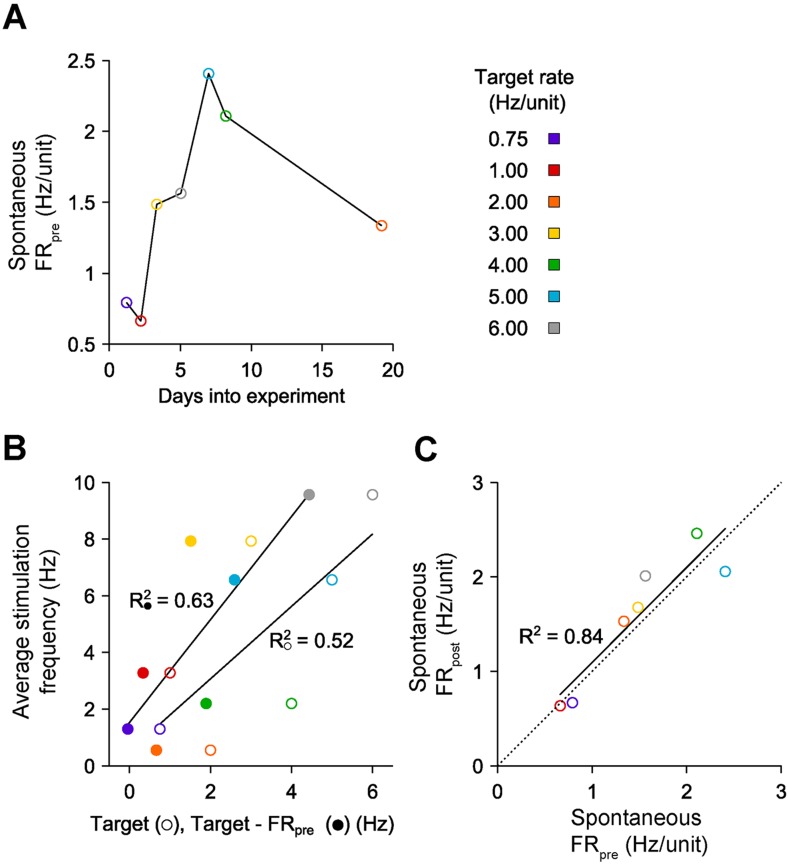
Characteristics of on-off control over weeks in vitro.(A) Spontaneous, pre-stimulation firing rates over the course of 7 long-term excitatory on-off control experiments with a single culture. Spontaneous excitability changes smoothly across the ∼20 days during which 12-hr firing rate control experiments were conducted. (B) The average stimulation frequency required to achieve firing rate control is plotted against the target rate (○) and the difference between the target rate the pre-stimulation spontaneous firing level (●). A linear fit is improved when the spontaneous excitability is taken into account, indicating that ongoing changes in network excitability influence the intensity of stimulation required to achieve firing rate control. (C) The spontaneous firing rate before each 12-hr protocol vs the spontaneous firing rate following each protocol exhibits a strong linear relationship (black line) that is not significantly different from identity (dashed line). This indicates the absence of a homeostatic decrease in network activity that might have resulted from chronically elevated firing levels in the absence of pharmacological agents.